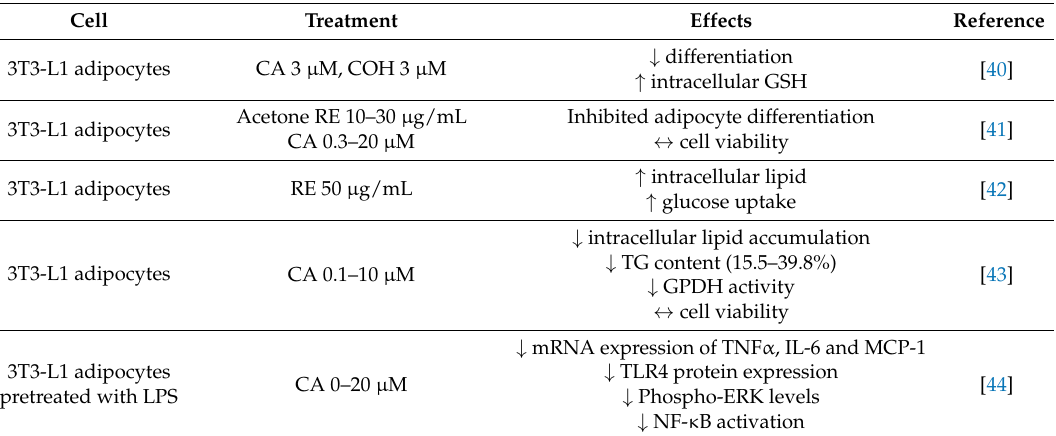
Table 4. Anti-diabetic Effects of Rosemary Extract and its Main Polyphenolic Constituents: in vitro studies